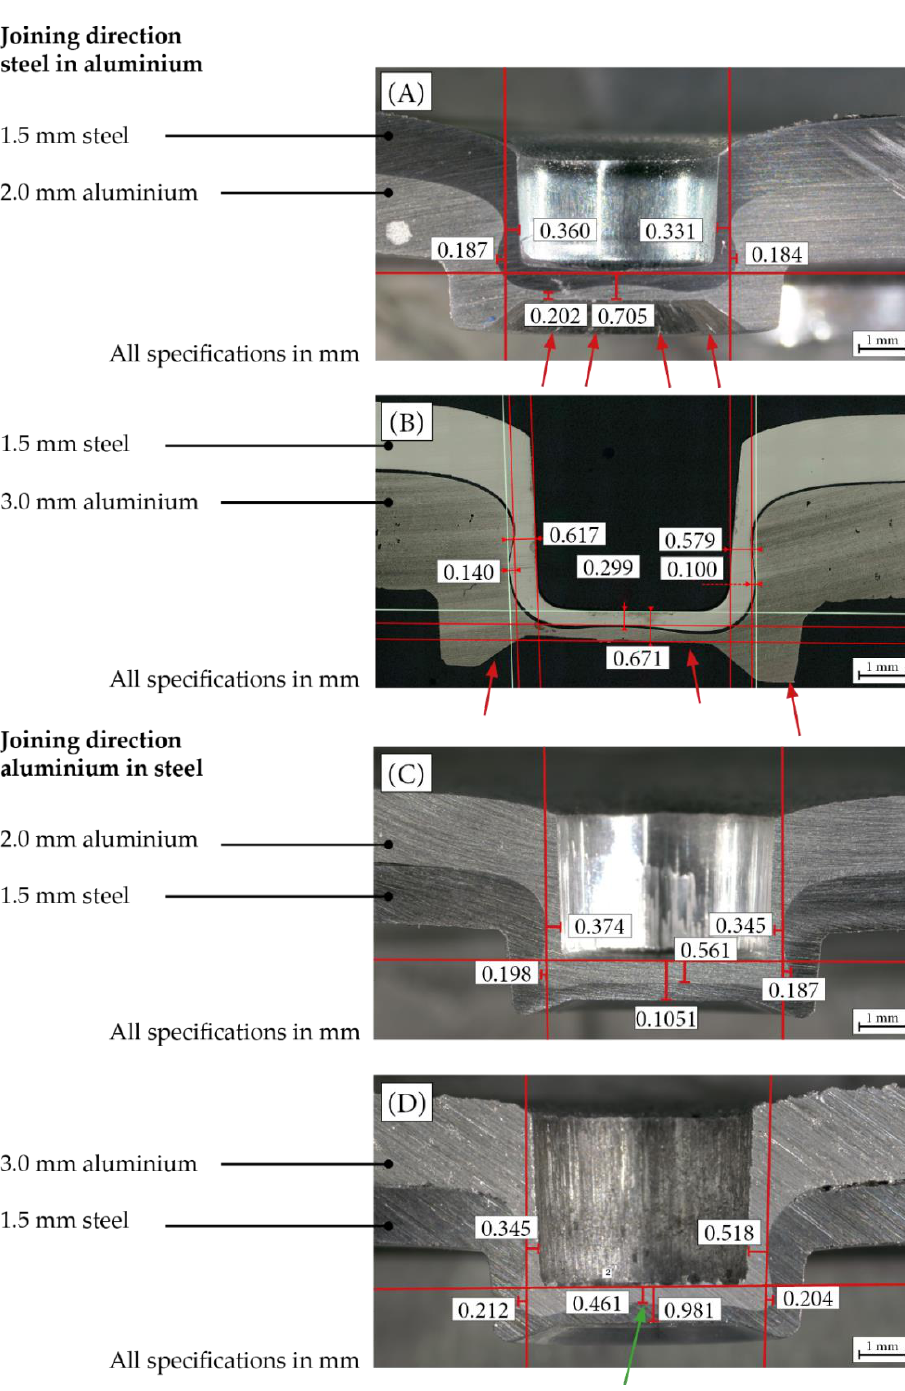
Figure 7. Microsection of a clinch joint. ( A ) punch-side HCT590X, die-side AlSi9 (2.0 mm), ( B ) punch-side HCT590X, die-side AlSi9 (3 mm), ( C ) punch-side AlSi9 (2.0 mm), die-side HCT590X, ( D ) punch-side AlSi9 (3.0 mm), die-side HCT590X.